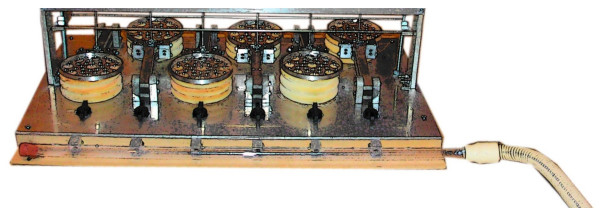
Mechanical lung model including the connection to the ventilator. Each bellows, or lung unit, is connected to a larger common tube, shown in front, through an adjustable valve, which can be seen in front of each bellow.